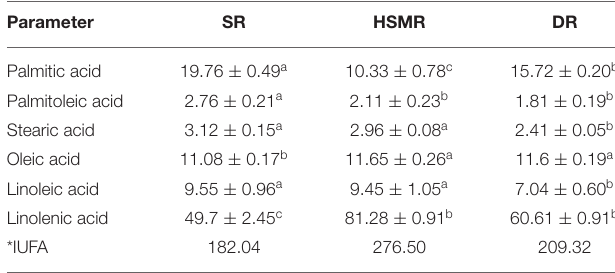
Differentlowercaselettersatthedataindicatesignificantdifferencesamongthreedifferent ecotypes of reed at p < 0.05 (one-way ANOVA). SR, swamp reed; HSMR, heavy salt meadow reed; DR, dune reed. * IUFA (index of unsaturated fatty acid) = 1 × %monenes + 2 × %dienes + 3 × %trienes.